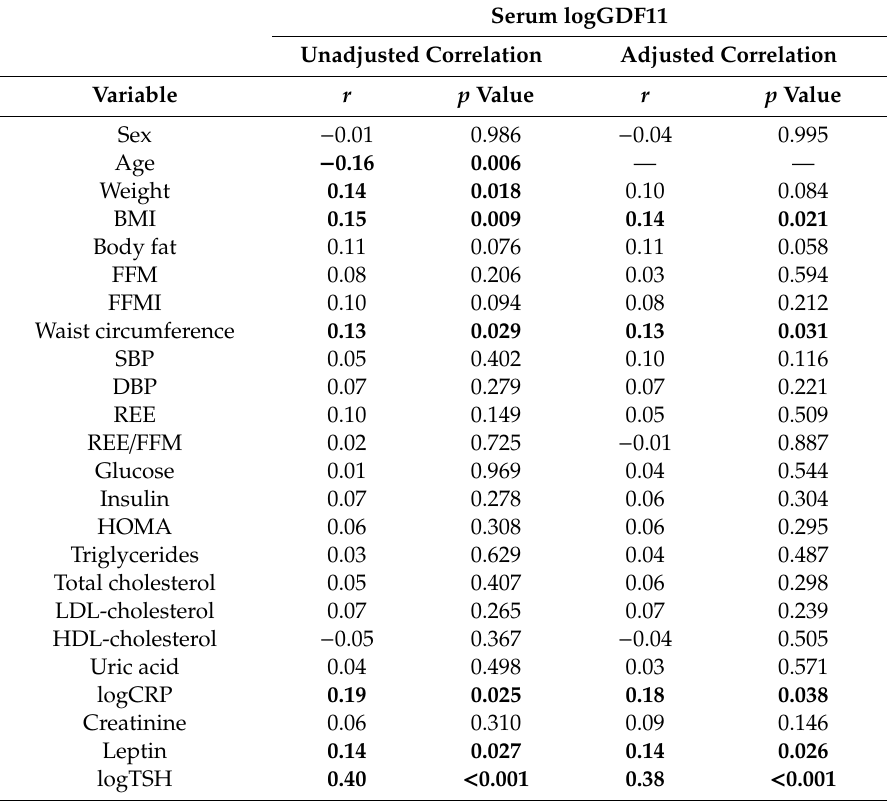
Table 2. Univariate analysis of the correlation between GDF11 and other variables, unadjusted and after adjusting for age. Serum logGDF11 Unadjusted Correlation